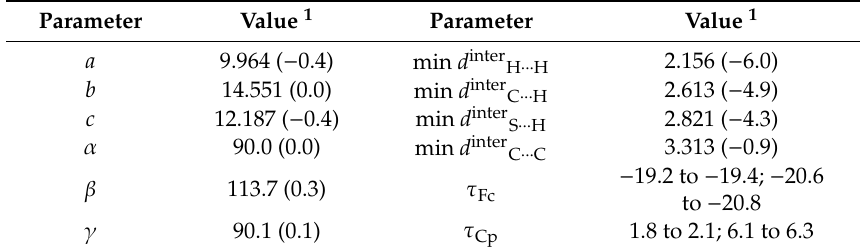
Table 8. Selected geometrical parameters ( a , b , c , min d inter , in Å; α , β , γ , τ Fc , τ Cp , in ◦ ) for the Fc 2 CS crystal structure optimized at the PBE-D / SVP level of